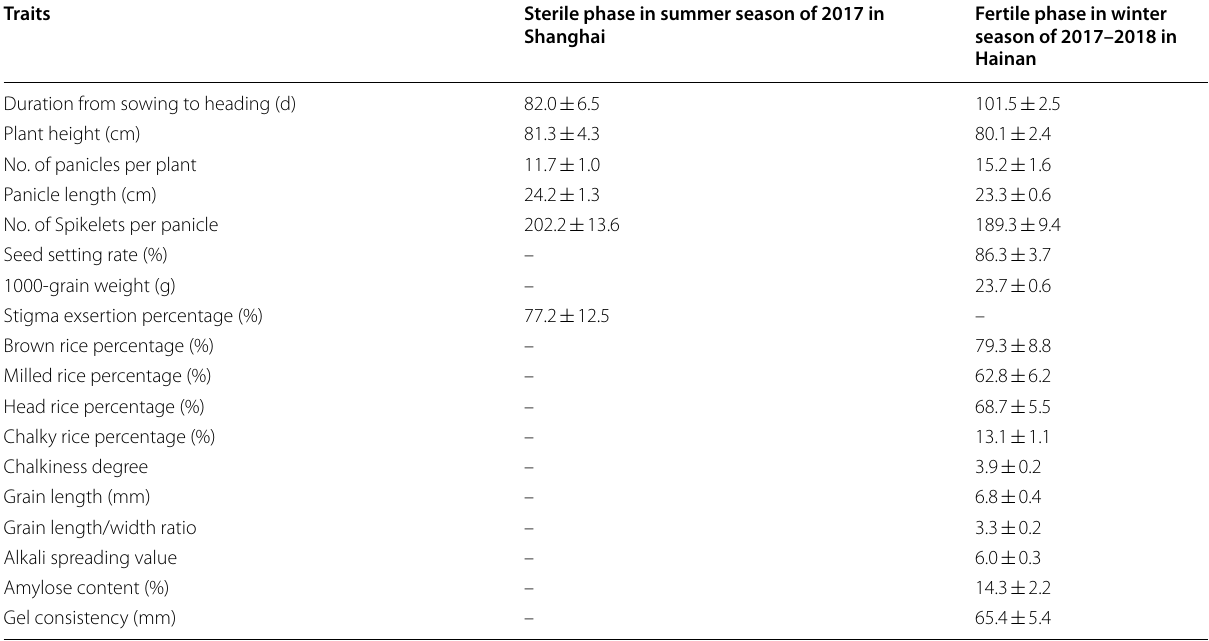
The values of agronomic traits are presented as means